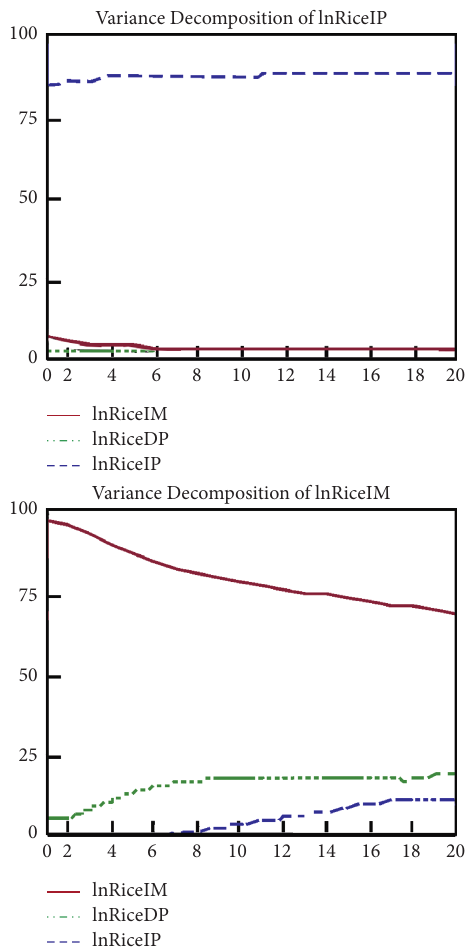
Figure 12: Variance decomposition analysis results for